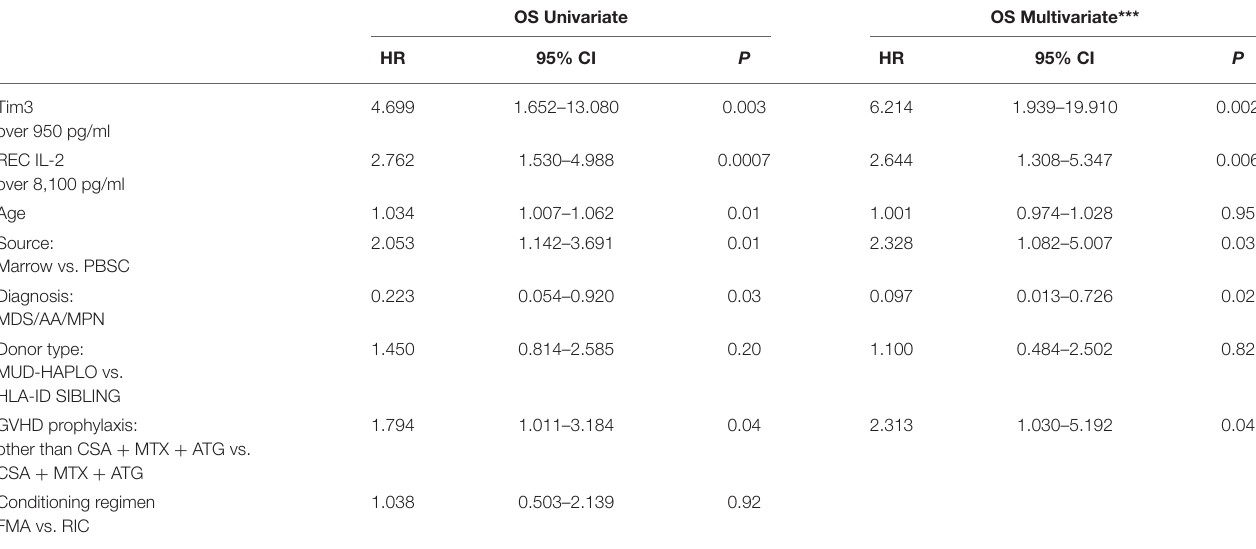
TABLE 4 | Univariate and multivariable analysis for OS incorporating values of Tim-3 and sIL2-R α dichotomized in two